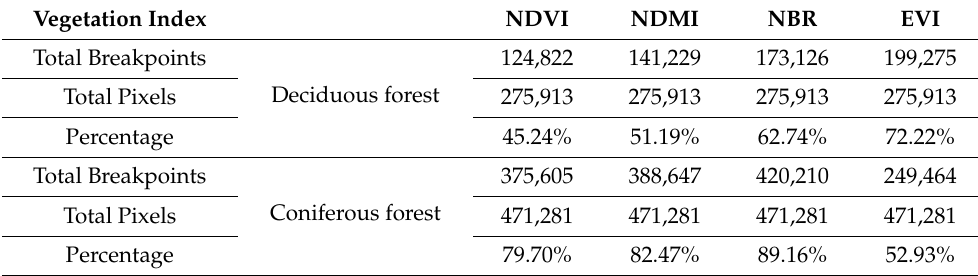
Figure 4. Magnitude values for all detected breakpoints in study area B according to threshold of − 0.05. Table 2. Percentage of all detected breakpoints in deciduous and coniferous